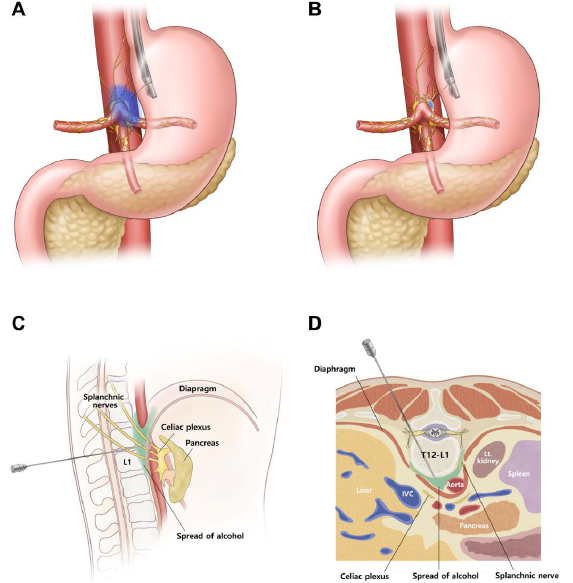
Figure 1. Schematic diagram of endoscopic ultrasound (EUS)-guided and percutaneous transdiscal celiac neurolysis. ( A ), EUS-guided celiac plexus neurolysis. ( B ), EUS-guided celiac ganglion neurolysis. ( C ), Sagittal view of percutaneous transdiscal celiac neurolysis. ( D ), Axial view of percutaneous transdiscal celiac neurolysis. Note that the needle is located at the retrocrural space. IVC, inferior vena cava; Lt. kidney, left kidney.